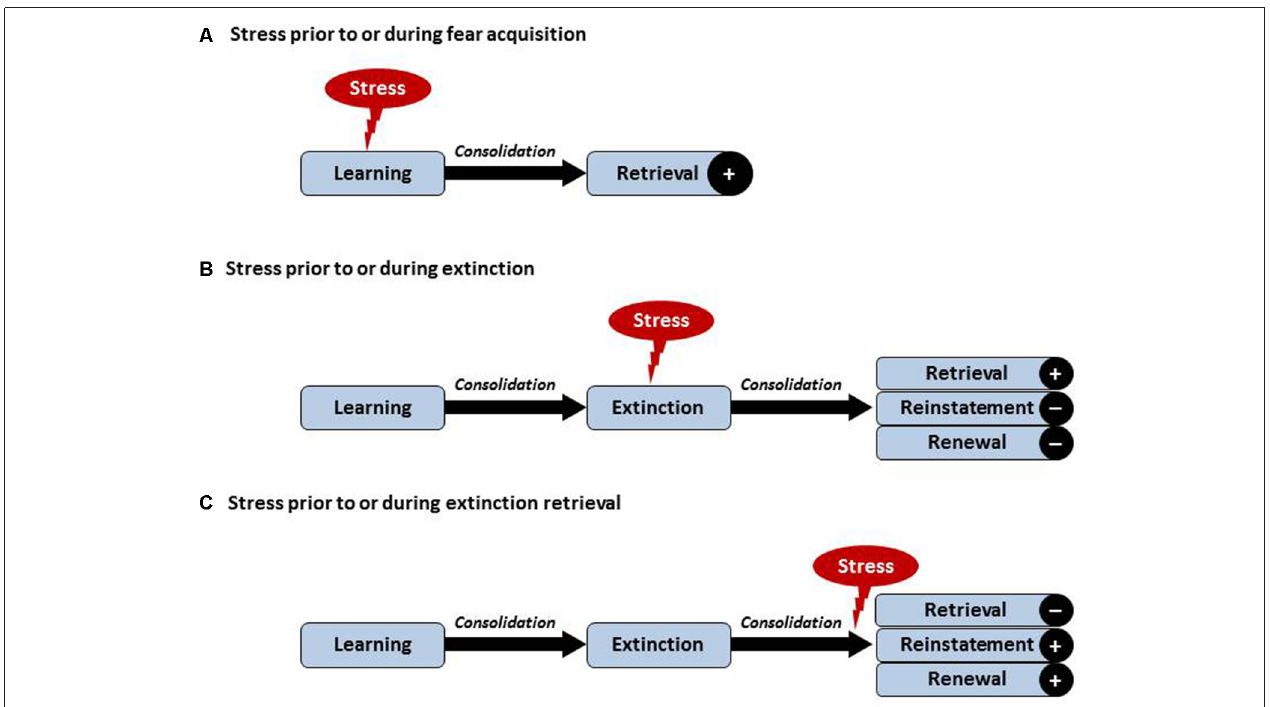
FIGURE 1 | Visualization of hypothesized effects of acute stress on learning and extinction of pain-related fear. Postulated effects depend on the timing of acute stress in relation to acquisition and/or extinction. (A) Acute stress just before or during acquisition may facilitate the formation and/or consolidation of pain-related fear, reflected by greater retrieval of pain-related fear. (B) Acute stress just before or during extinction learning may improve consolidation of the extinction memory trace, possibly resulting in enhanced retrieval of the extinction memory and hence reduced reinstatement or renewal. (C) Post-extinction stress occurring just prior to or during extinction retrieval may impair the retrieval of the extinction memory and result in enhanced reinstatement or renewal effects. Note that chronic stress or affective comorbidity may differentially affect these processes involving central and peripheral mechanisms of the inter-connected stress and pain systems (not shown here, see